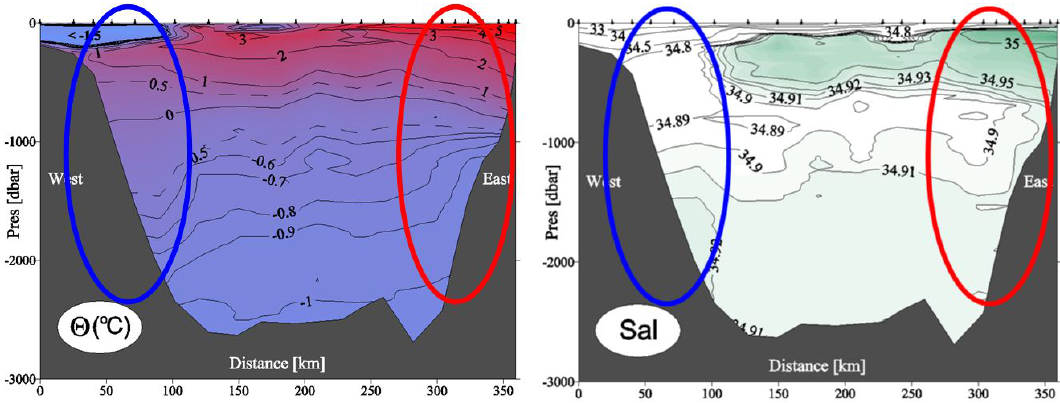
Fig. 20. Potential temperature and salinity sections from Fram Strait taken in 1997 by RV Lance. The West Spitsbergen Current and the East Greenland Current are indicated by red and blue ellipses